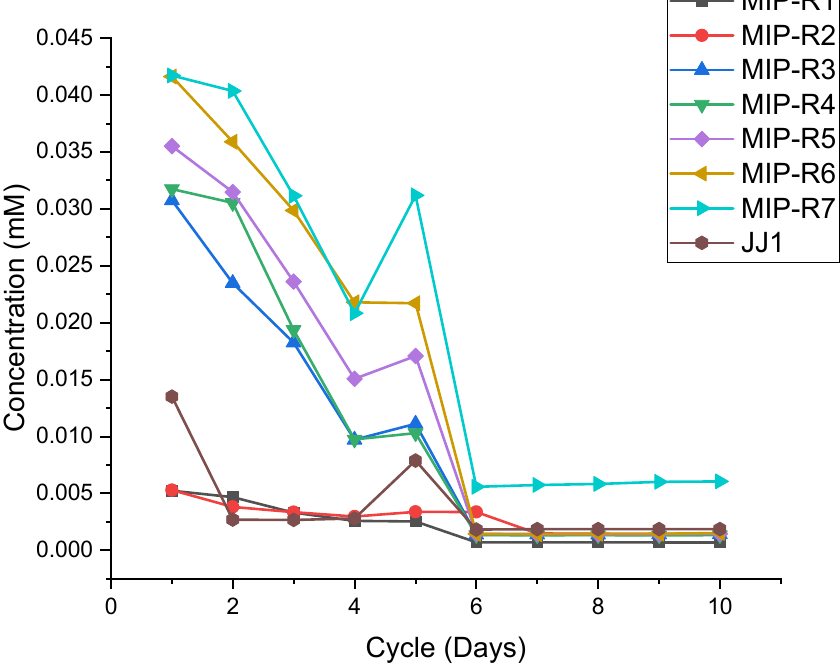
Figure 5. Demonstrating the MIP release and uptake kinetics, compared to JJ1. The concentration of Timolol, in mM, is shown on the y-axis. The x -axis demonstrates the cycle (in day) of measurement. All samples demonstrate a steady decline from this initial concentration until four